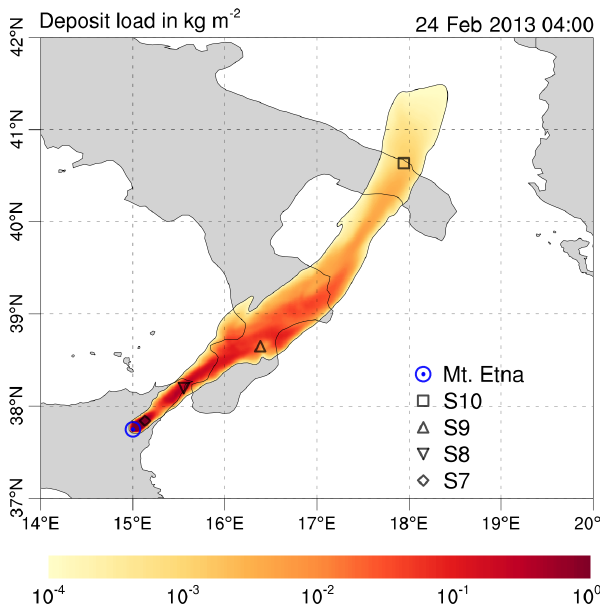
Figure 6. Tephra fallout deposit from the Etna-2013 test case. The spatial distribution of the modelled tephra loading coincides with the locations of sampling sites. Sites S7–S10 are indicated on the map by symbols. Proximal sites S1–S6 ( < 16km from the source) are not shown for clarity.